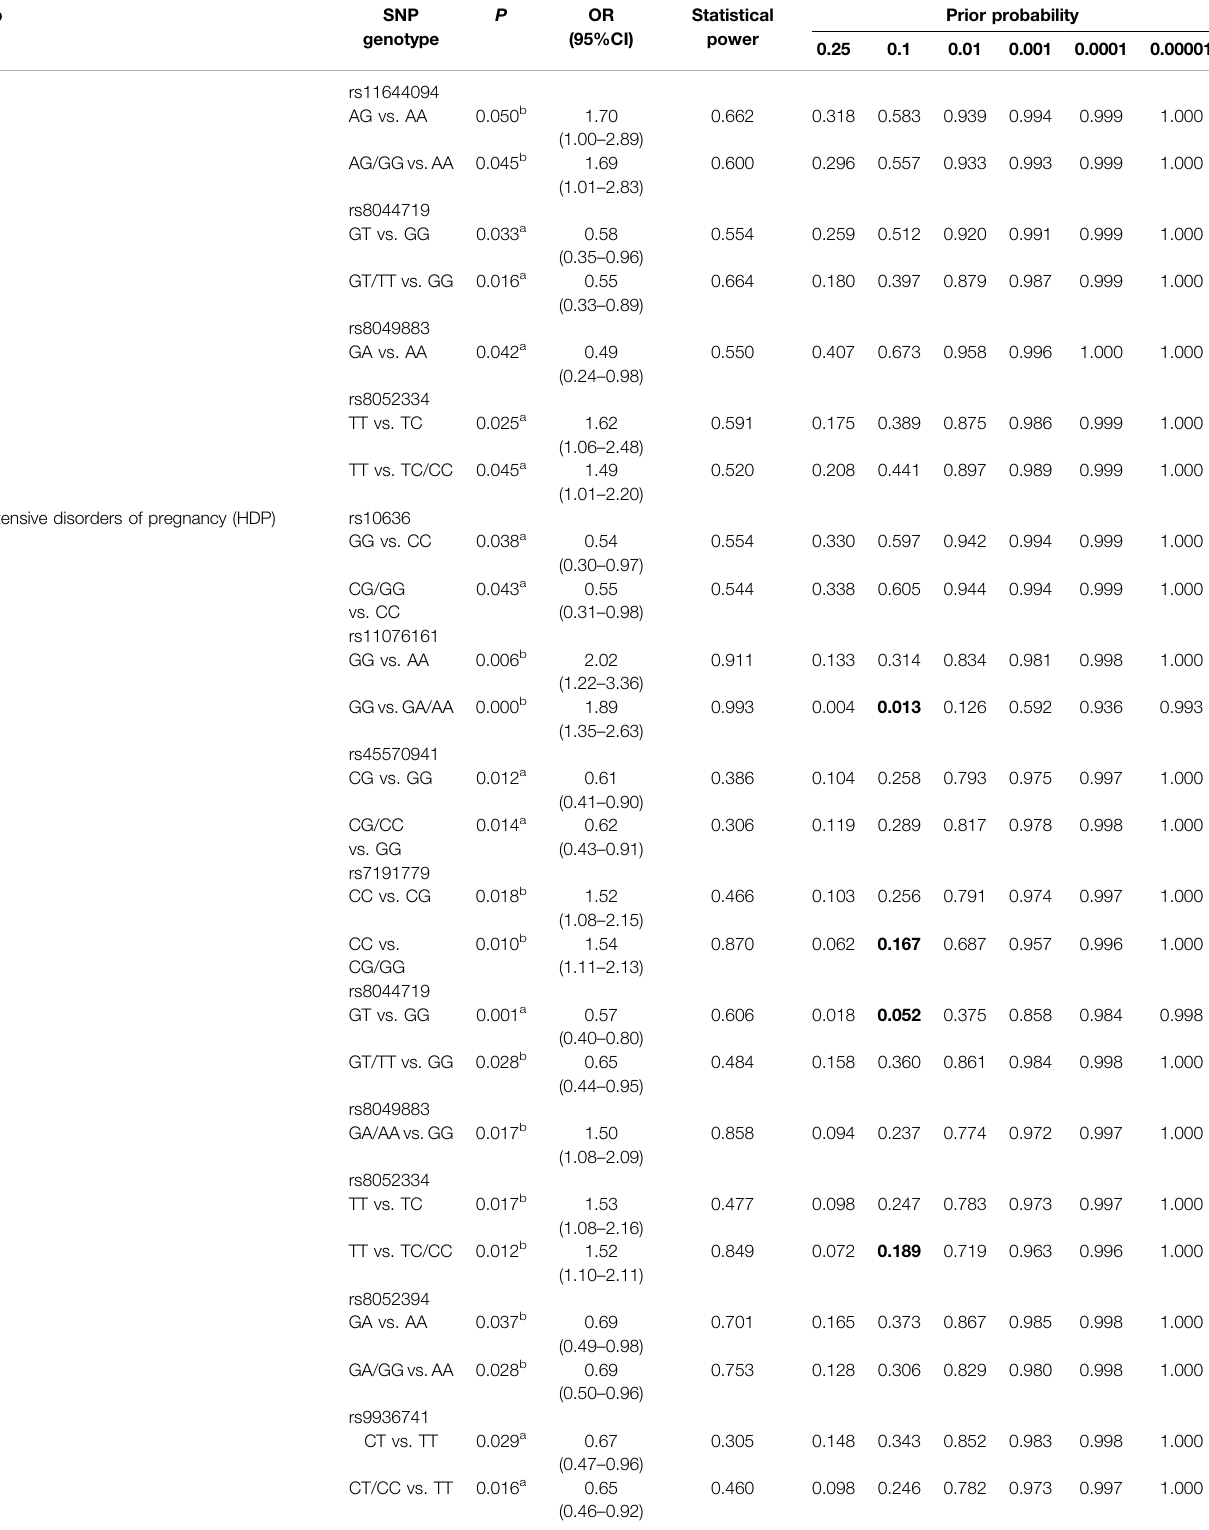
a Unadjusted for age and BMI in a logistic regression model in Table 2 and Table 3 . b Adjusted for age and BMI in a logistic regression model in Table 2 and Table 3 . Figures in bold type indicate statistical signi fi cance at the 0.2 level. Frontiers in Genetics |